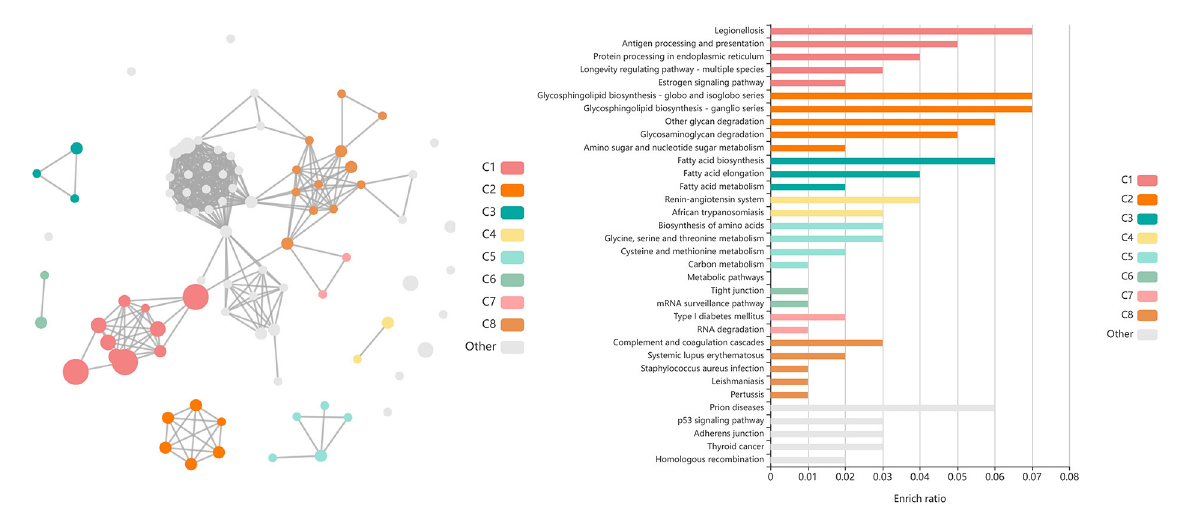
FIGURE8 Clustering of enriched KEGG pathways by term identity from KOBAS-i analysis of DEGs identified between vaccinated and non-vaccinated calves at T3. Each node represents an enriched term, with color corresponding to the unique cluster based on term identity. Each edge (line between nodes) represents a significant correlation between pathway terms. Bar graphs represent the pathway terms found within each pathway (by color) and the level of enrichment (Enrich ratio). KEGG pathways identified between vaccine groups at T3 clustered into eight unique clusters. Gray nodes and bar graphed terms represent enriched pathways which did not associate within the clustering